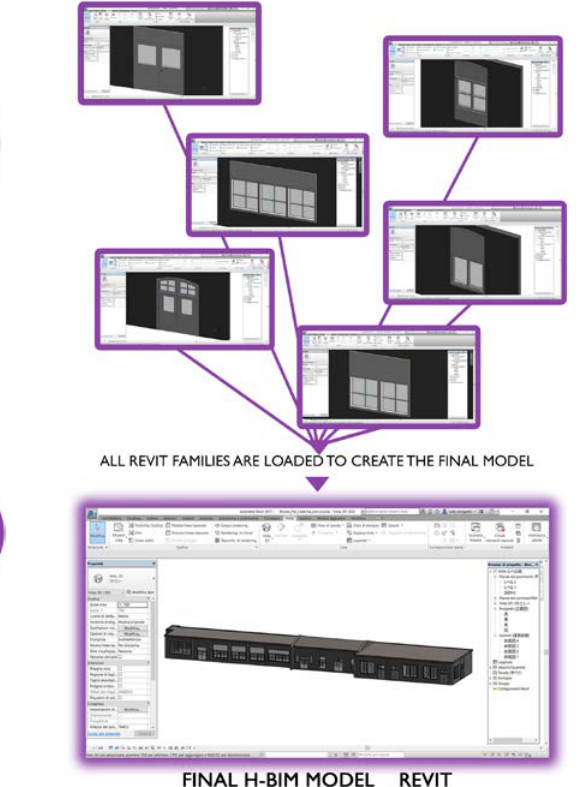
Figure 20: Revit Family created imported into the